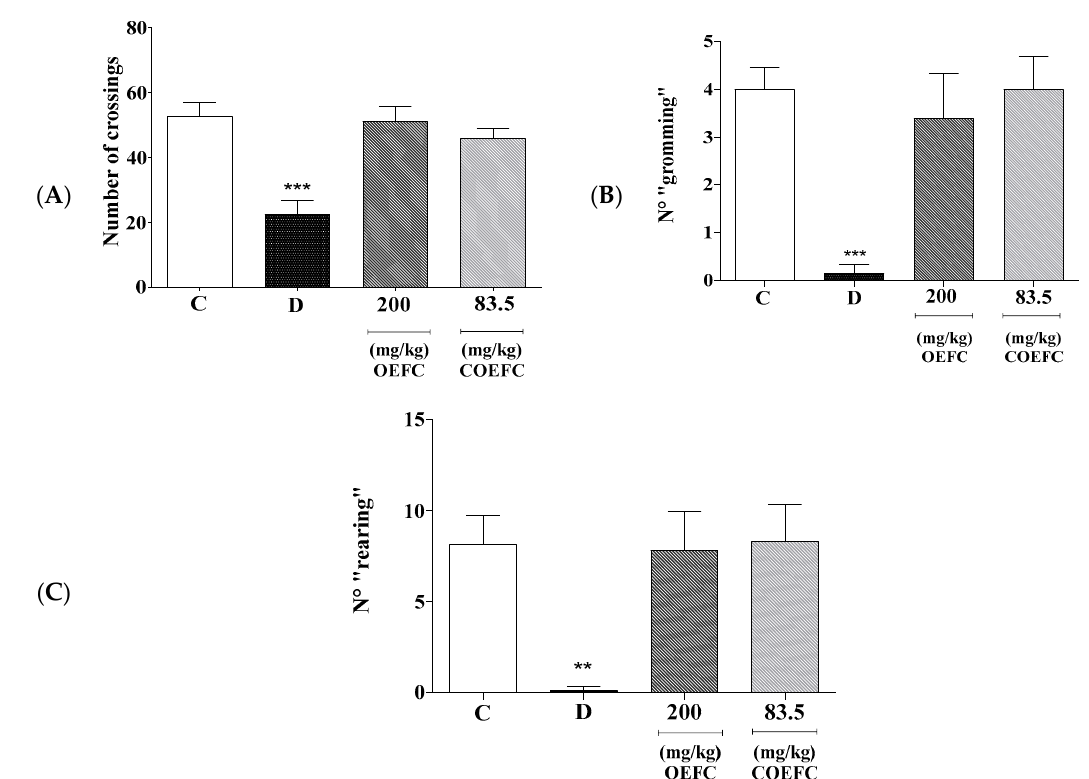
Figure 1. Effect of the C. rhamnifolioides leaf essential oil (OEFC, 200 mg/kg/v.o.) and β -cyclodextrin inclusion complex (COEFC, 83.5 mg/kg/v.o.) on the number of crossings ( A ), grooming ( B ), and rearing ( C ) in the open field test. The effects of the OEFC (200 mg/kg/v.o.) and COEFC (83.5 mg/kg/v.o.) on the number of crossings ( A ), grooming ( B ), and rearing ( C ) in the open field test are outlined below. Groups: control-C (0.1 mL/10g/v.o.), Diazepam-D (5 mg/kg/v.o.), OEFC (200 mg/kg/v.o.) and COEFC (83.5 mg/kg/v.o). Values represent the mean ± S.E.M. (standard error of the mean) for groups of 6 animals with: ** p < 0.01; *** p < 0.001 when compared to the control group; statistical analysis: ANOVA followed by Dunnett’s Test with multiple comparisons.